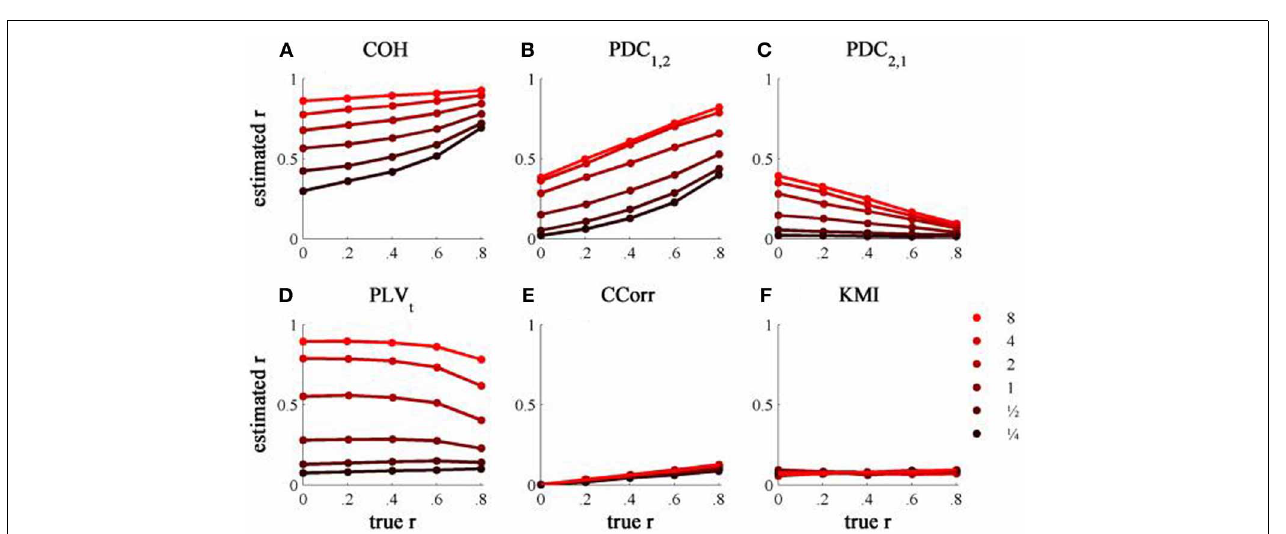
(D) time-averaged phase-locking value, (E) circular correlation coefficient and (F) Kraskov mutual information. For COH, PDC and PLV, as all values are > 0, bias = RMSE are equal. For CCorr and KMI, where values may be ≤ 0, bias (cid:4)= RMSE.